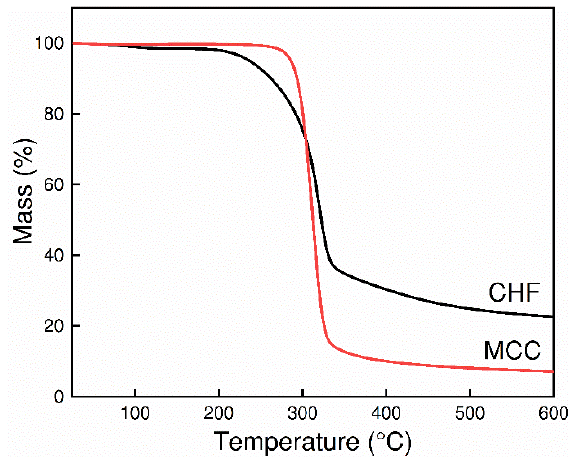
Figure 8. Weight loss of MCC and CHF by TGA.